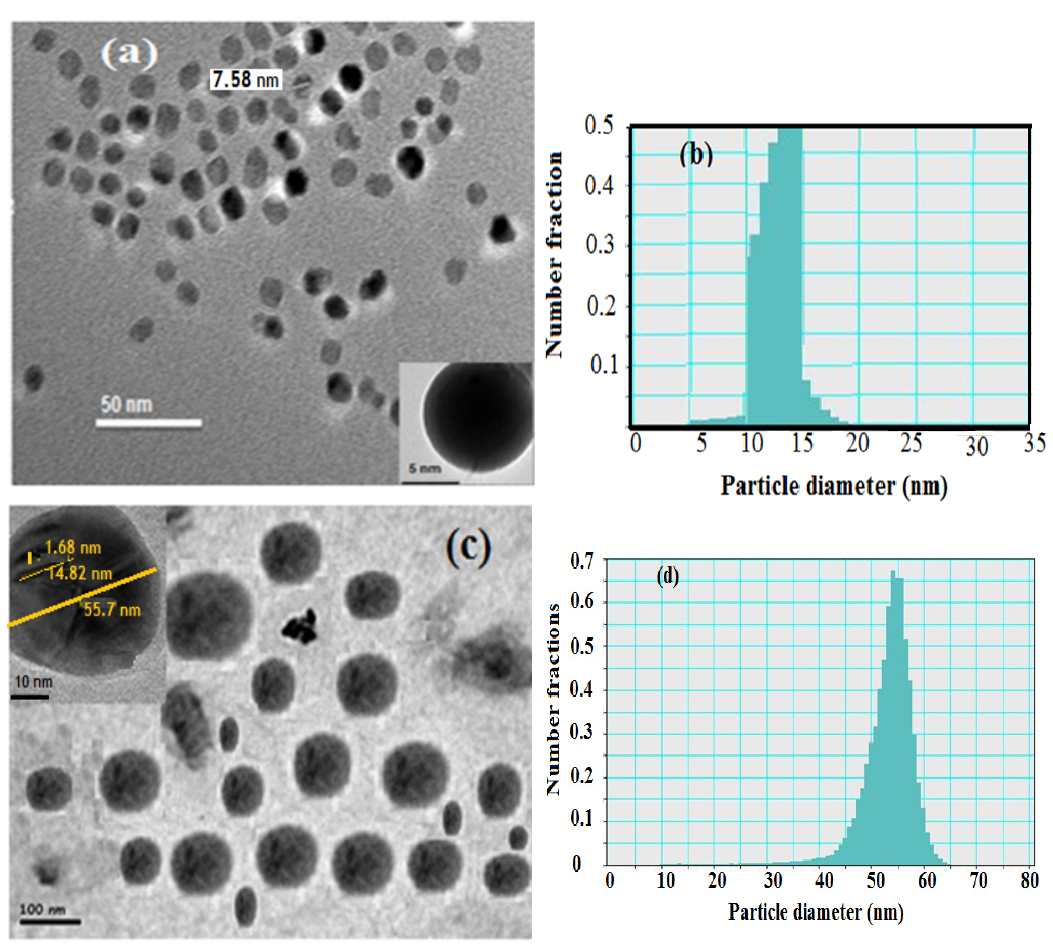
Figure 2. TEM micrographs and histograms of ( a ) and ( b ) oleic coated magnetite, ( c ) and ( d ) PAMPS-Na-co-St/magnetite